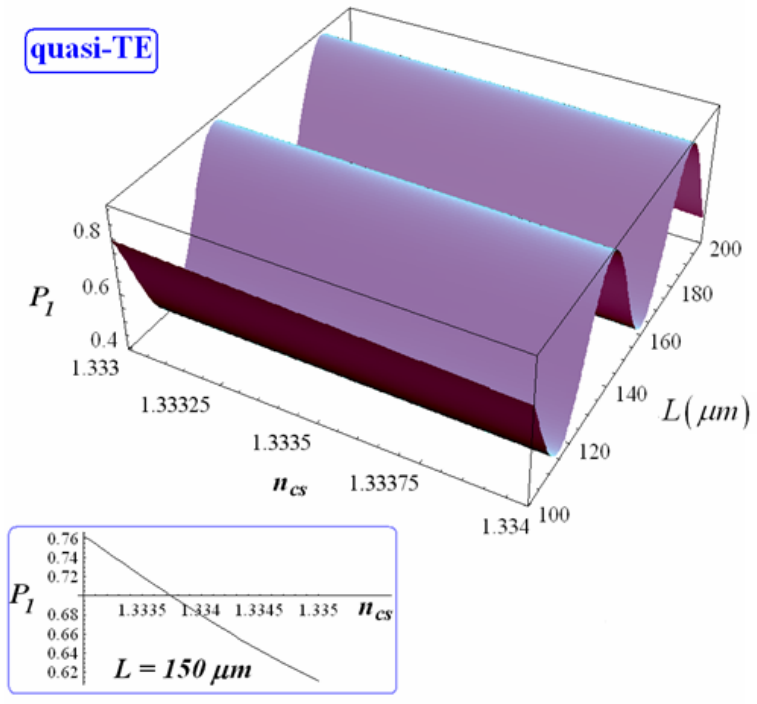
Figure 10 . Normalized optical power exiting from W1 and its dependence on L and n (quasi-TE, d = 1 μ m). In the inset the dependence of P μ m.